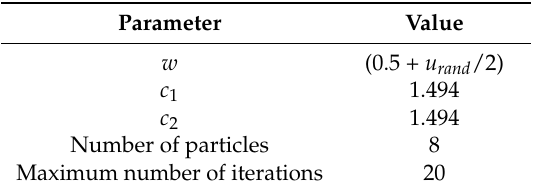
Table 2. Particle swarm optimization (PSO)